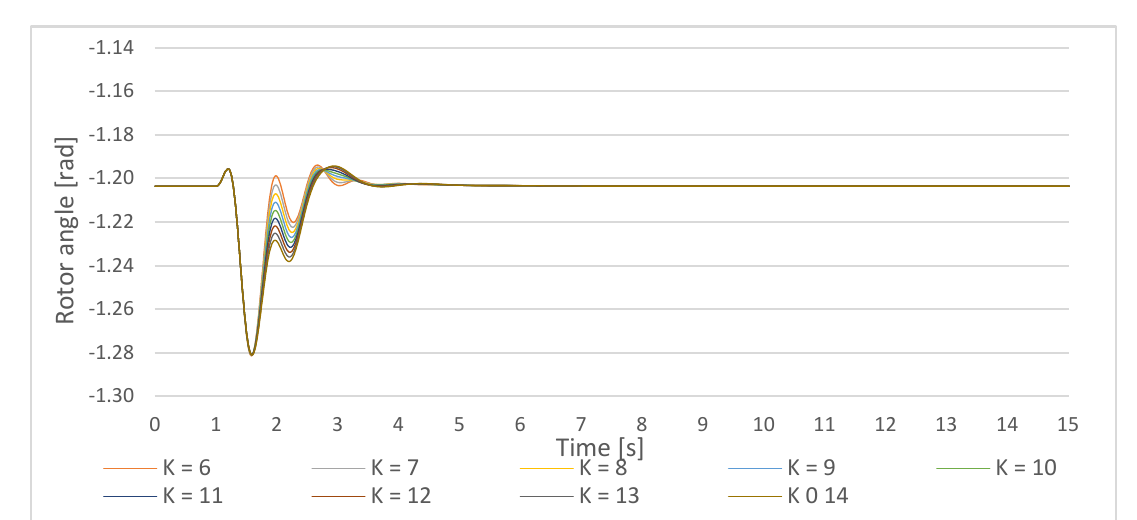
Figure 23. Gen1 rotor angle response on a small disturbance with PSS parameters T = 0.5 s, the PSS gain increase in the lower cluster 1-K i,ln = 6–10, and the upper cluster 1 K i,um = 10–14.